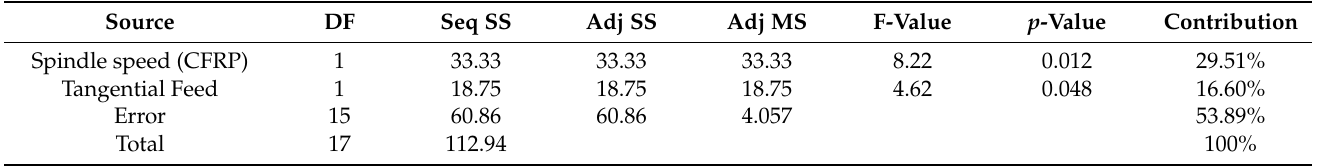
Table 6. Analysis of variance of the circularity error of